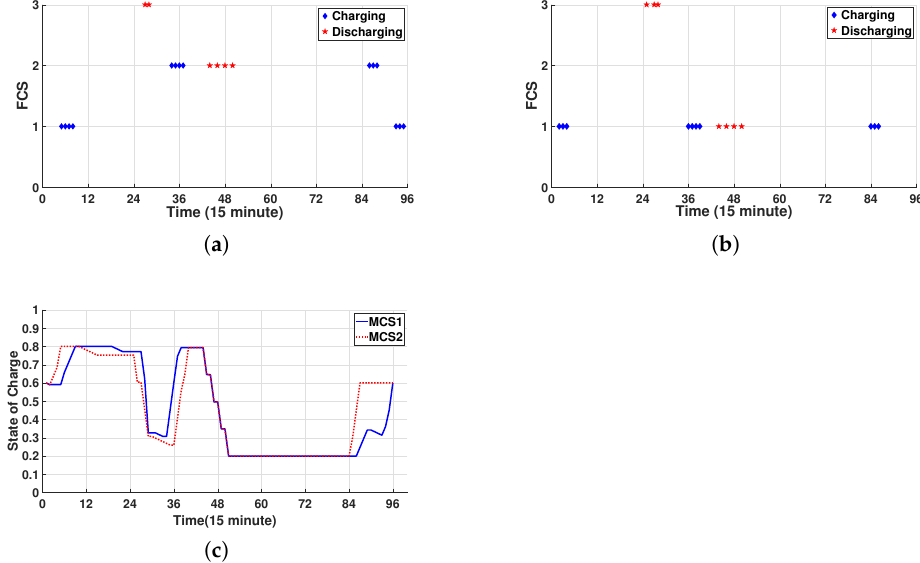
Figure 6. Spatial-temporal schedule for charging and discharging of MCSs. ( a ) Location of MCS1. ( b ) Location of MCS2. ( c ) State of charge (SOC) for MCS1 and